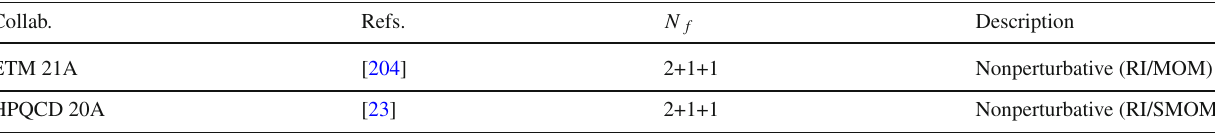
Table 93 Renormalization in the determinations of m c with N f = 2 + 1 + 1 quark flavours